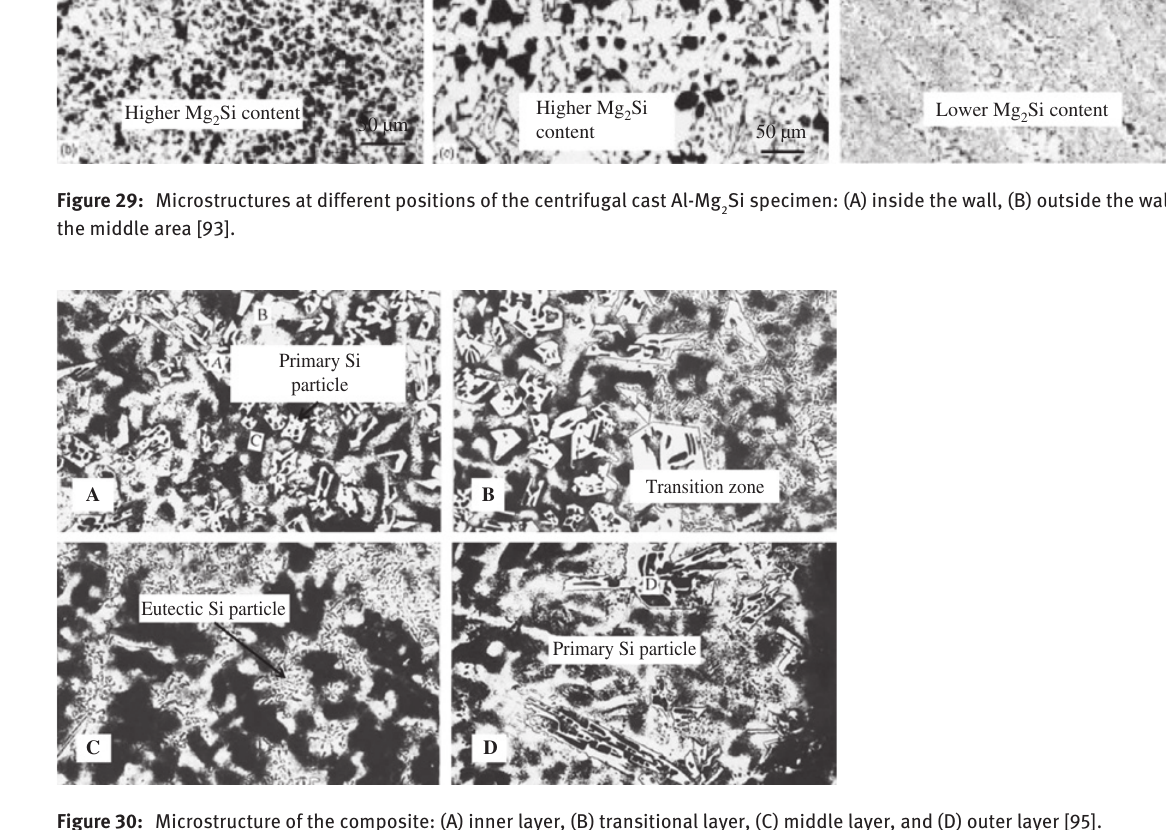
Figure 30: Microstructure of the composite: (A) inner layer, (B) transitional layer, (C) middle layer, and (D) outer layer